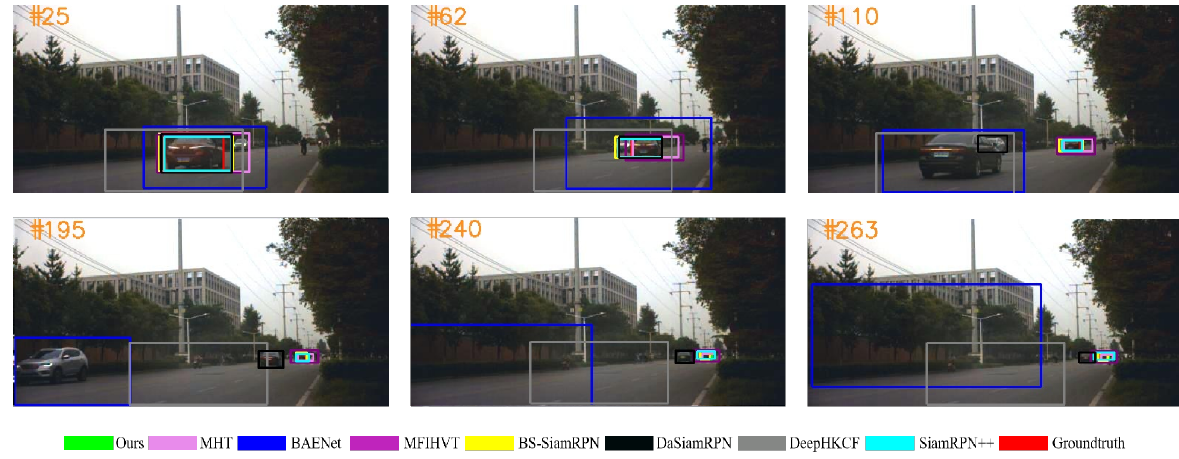
Figure 9. Qualitative results on the car3 sequence.